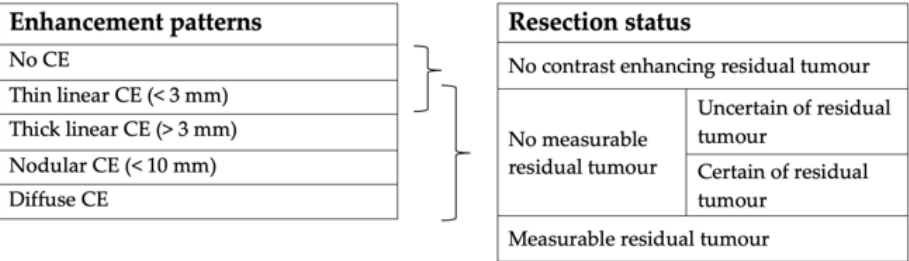
Figure 1. Overview of the data categorisation process. Enhancement patterns are specified in the